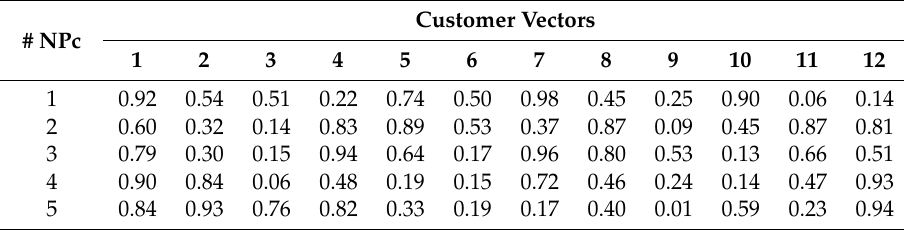
Table 6. NPc vector of 1 ×